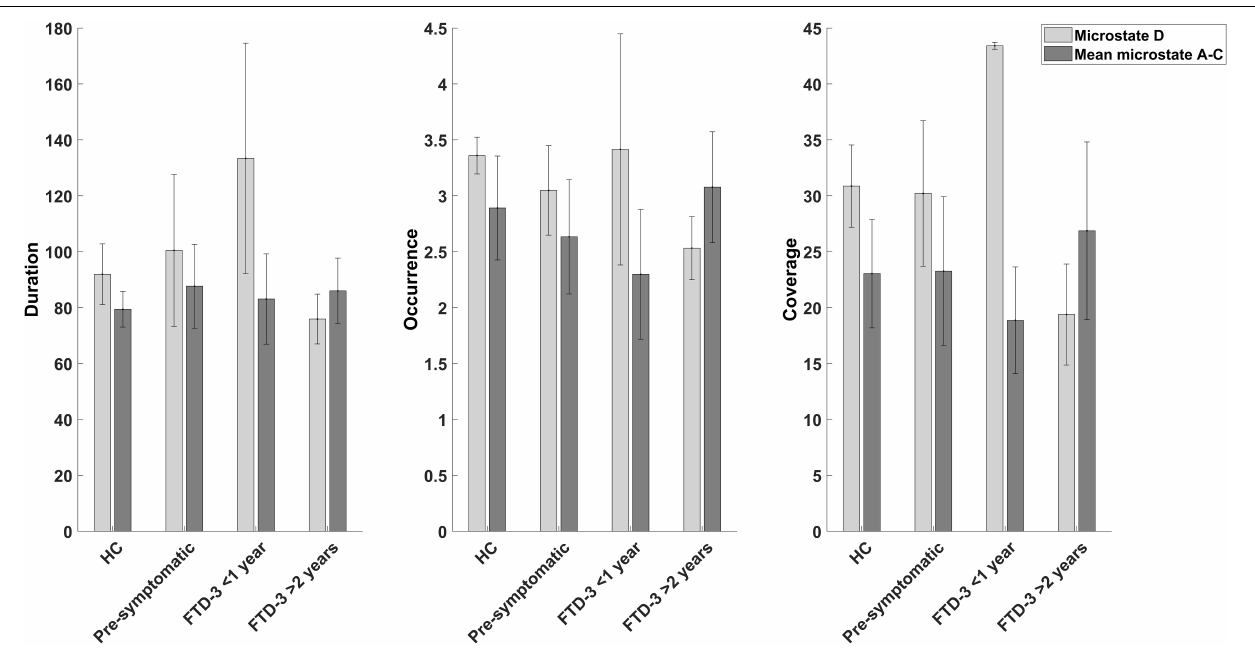
FIGURE 1 | Bar graphs showing the mean and standard deviation of duration, occurrence, and coverage for microstate D and the mean of the other microstates (A, B, and C) for the controls ( n = 6), pre-symptomatic carriers ( n = 5), patients with CHMP2B-FTD with recent ( < 1 year) onset of symptoms ( n = 2), and patients who had been symptomatic for a longer ( > 2 years) period ( n =